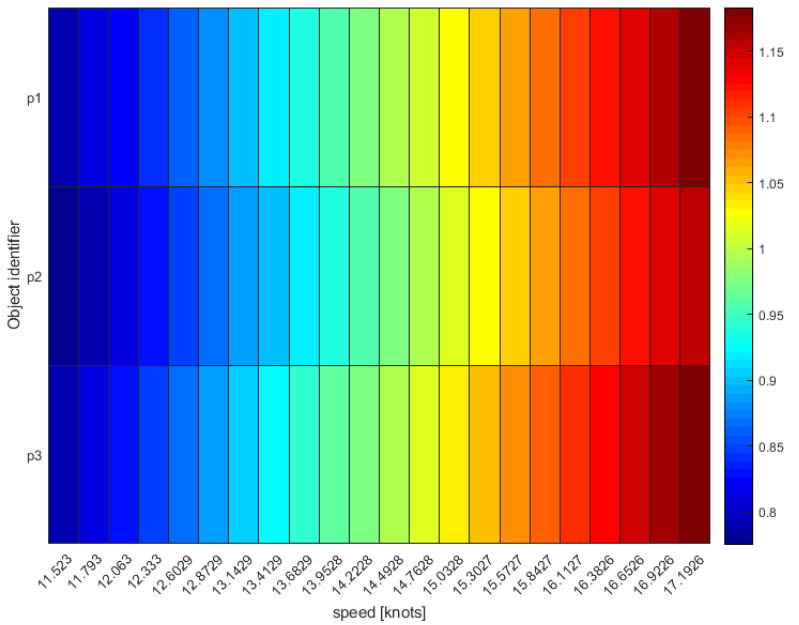
Figure 10. Graphical representation of the estimated distance travelled by vessel towards the offshore platforms p1, p2 and p3.